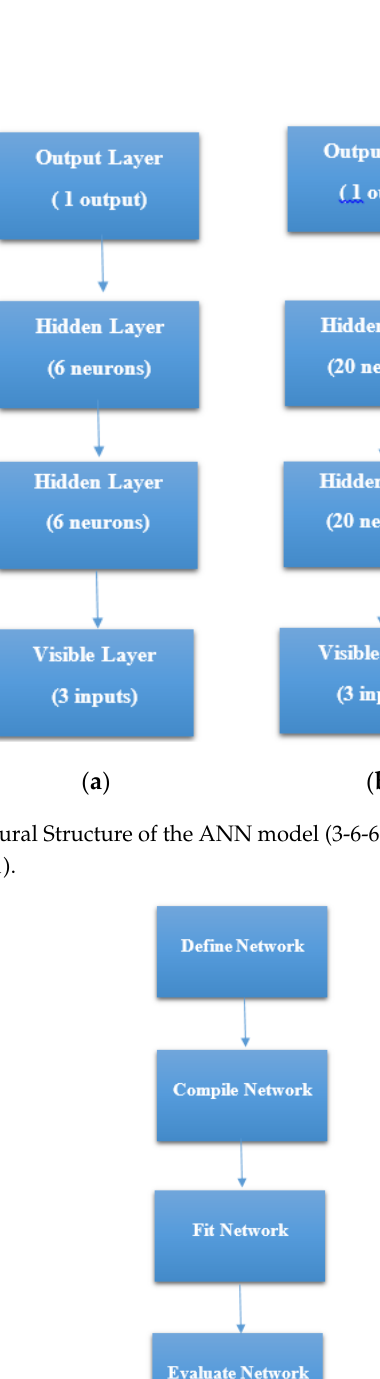
Figure 8. ( a ) The Architectural Structure of the ANN model (3-6-6-1) with 73 trainable parameters; ( b ) The Architectural Structure of the ANN model (3-20-20-1) with 521 trainable parameters.